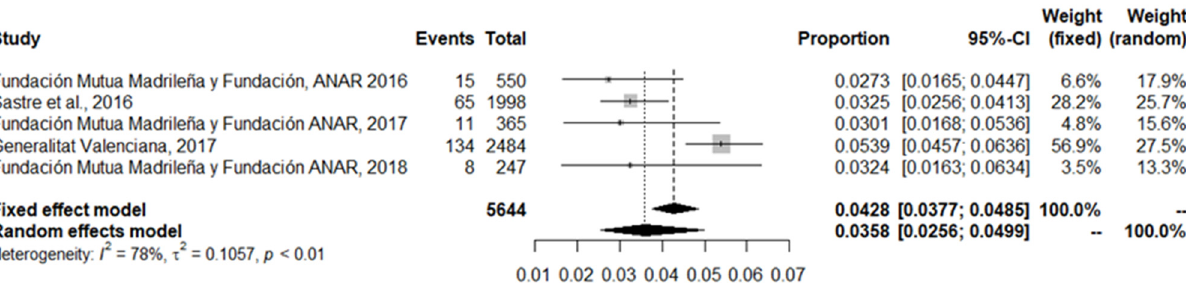
Figure 6. Forest plot of gender-based bullying victimisation among pre-identified victims’ studies.